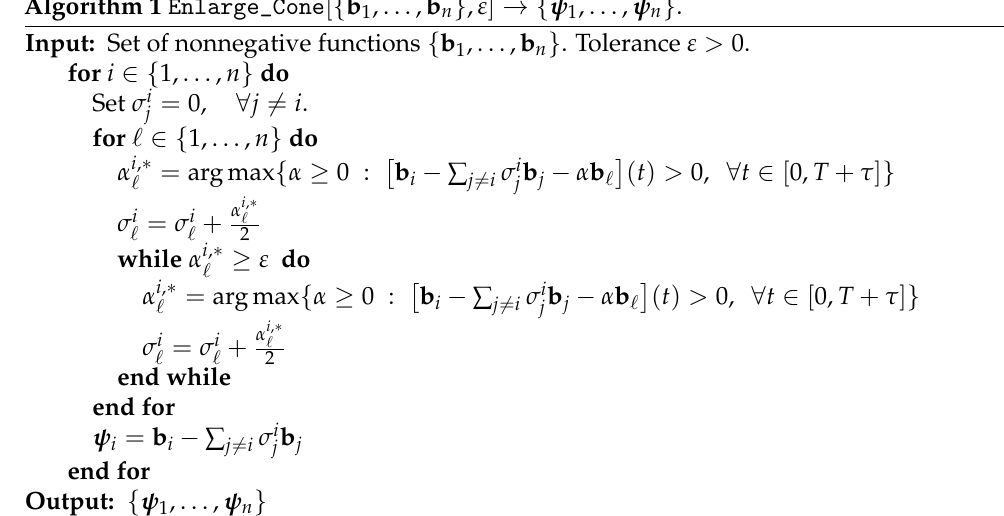
Algorithm 1 Enlarge_Cone [